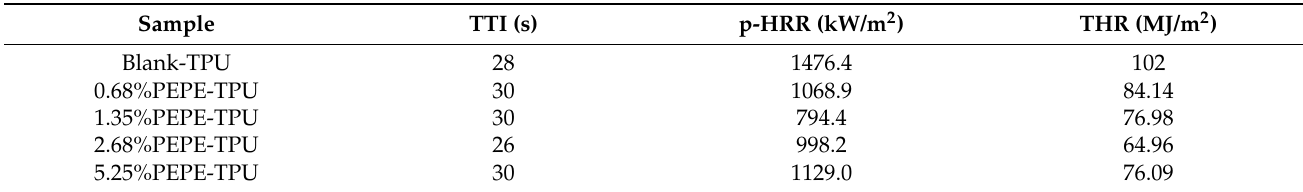
Figure 4. Digital photographs of char after cone test. Table 4. Cone calorimetry data of flame-retardant TPU with PEPE.